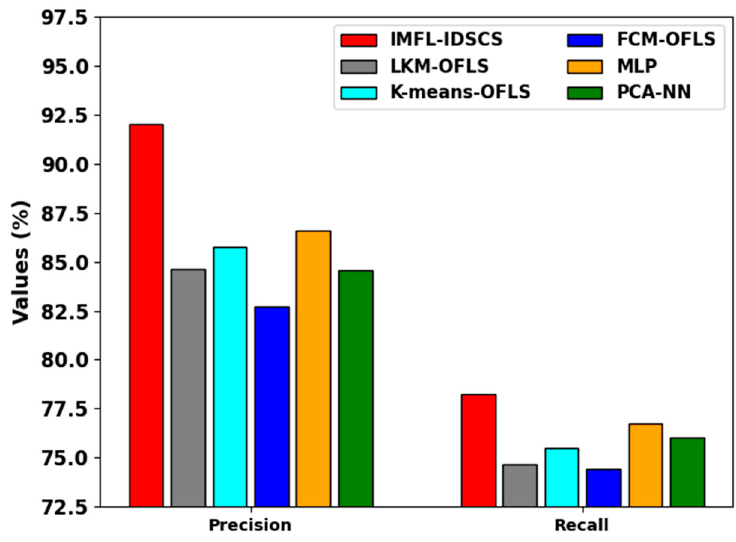
Figure 11. Prec n and reca l analysis of IMFL-IDSCS system with other Figure 11. 𝑃𝑟𝑒𝑐 (cid:3041) and 𝑟𝑒𝑐𝑎 (cid:3039) analysis of IMFL-IDSCS system with other approaches.